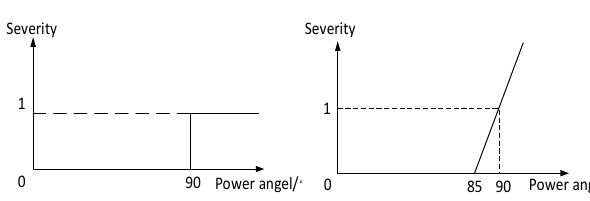
Figure 3. Power angle difference severity (PADS) function.